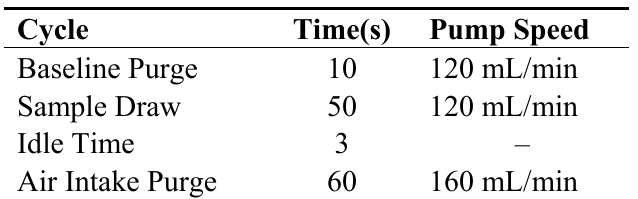
Table 4. E-nose parameter setting for Harumanis